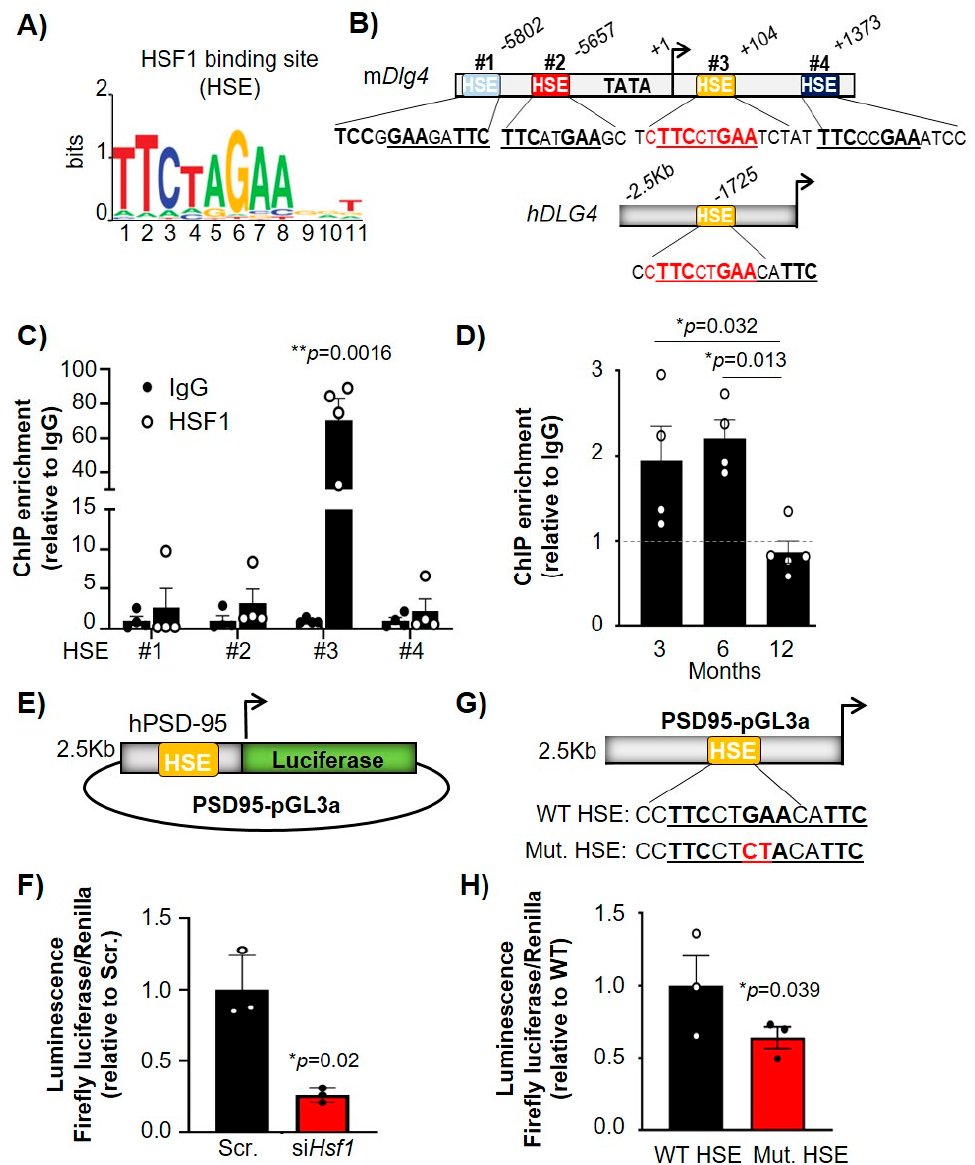
Figure 4. HSF1 binds to HSE within the mouse and human Dlg4 (PSD-95) promoter/gene and directly regulates Dlg4 transcription. ( A ) HSF1-binding motif (HSE) represented by MotifExpress. ( B ) Genetic diagram of the HSEs found in the promoter and intergenic region of PSD-95 identified in silico. Mouse Dlg4 (mPSD-95) and human DLG4 promoter (h DLG4 ) share an identical HSE (yellow). All HSE sequences are shown in 5 ′ -3 ′ as they appear in the sense (top) strand. Note that HSE #1 motif is present in the antisense (bottom) strand and represents an inverted HSE. ( C ) HSF1-ChIP for the four different HSEs identified in the m Dlg4 gene. Data is relative to IgG ( n = 4). ( D ) HSF1-ChIP for HSE #3 in the striatum of WT mice at 3 ( n = 4), 6 ( n = 4) and 12 months ( n = 6). ( E ) Diagram of PSD95-pGL3a vector expressing Luciferase under control of h DLG4 promoter. ( F ) Luciferase activ- ity in ST Hdh Q7 cells transfected with non-targeting siRNA (Scr.) or si Hsf1 . Data is normalized to Renilla luciferase and relativized to Scr. ( G ) Diagram of PSD95-pGL3a containing a WT HSE or a mutant HSE (Mut. HSE). ( H ) Luciferase activity in ST Hdh Q7 cells transfected with PSD95-pGL3a containing WT or Mut. HSE. Data is normalized to Renilla luciferase and relativized to WT. Error bars denote mean ± SEM. Unpaired Student’s t -test in (C), (F), (H) and One-way ANOVA with Tukey’s post-hoc test in (D). * p < 0.05, ** p < 0.01. To determine whether HSF1 directly regulated the expression of PSD-95 we con- ducted luciferase assays with a reporter containing the h DLG4 promoter, which had HSE